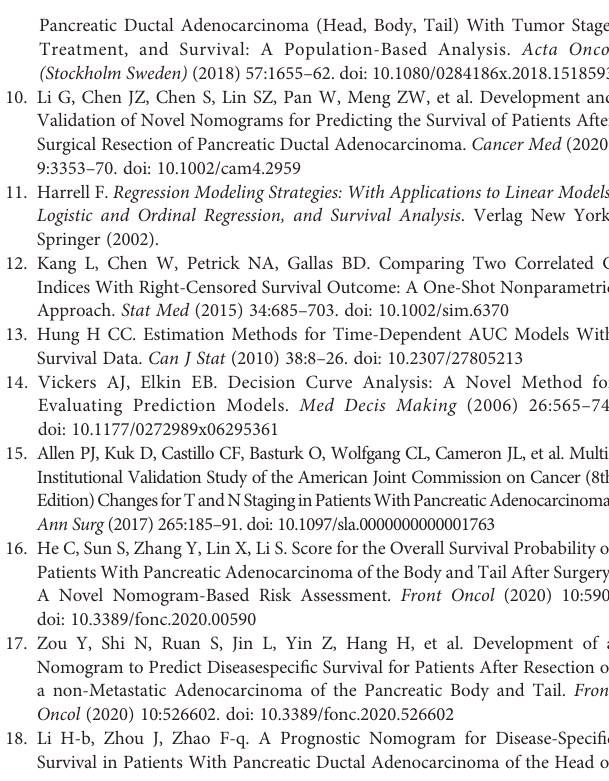
Supplementary Figure 1 | ROC curve analysis and comparison of the nomograms with the 8thAJCC stages. ROC curve analysis of the nomograms for predicting (A) 1-, 2-, and 3-year survival in the PDAC group; (B) 1-, 2-, and 3-year survival in the PHC; and (C) 1-, 2-, and 3-year survival in the PBTC